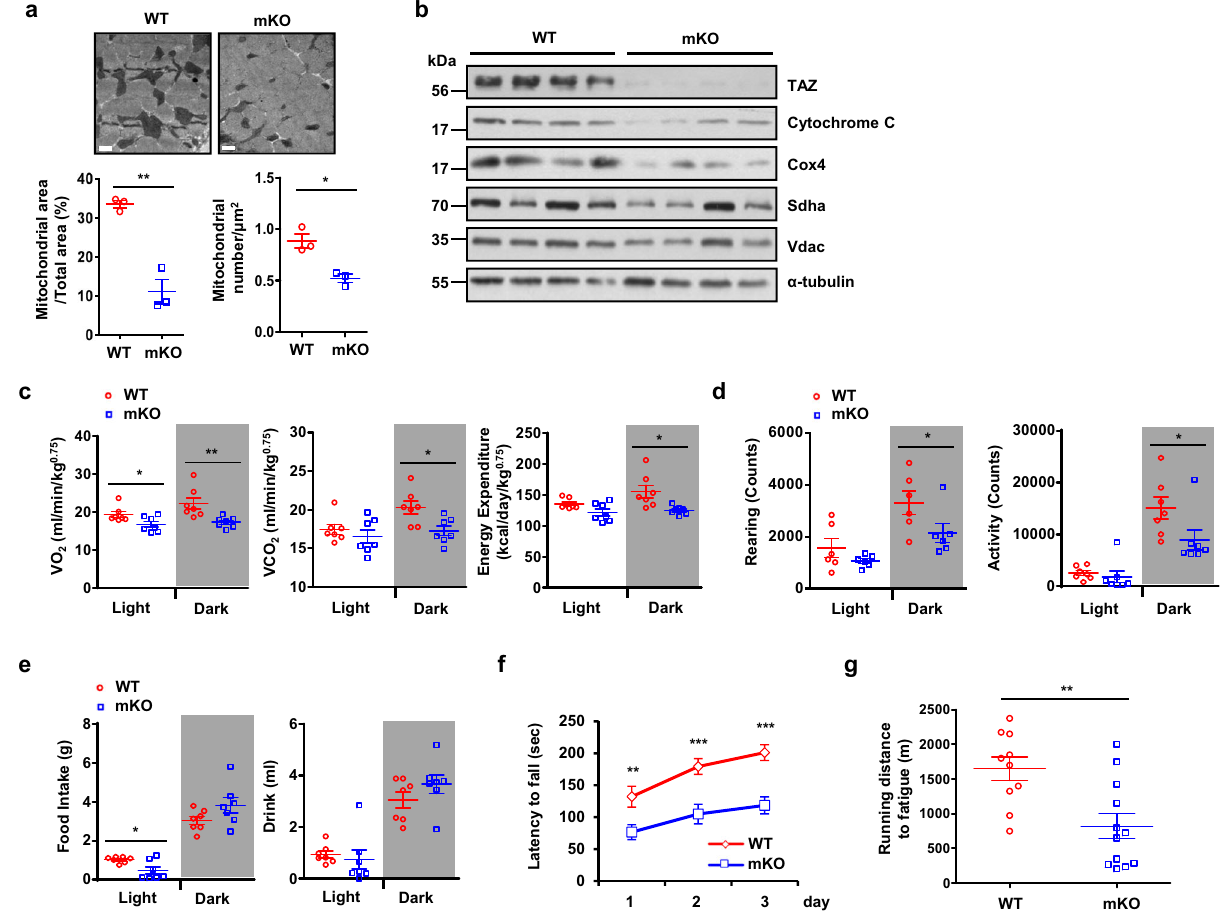
Fig. 1 TAZ knockout in muscle decreases mitochondrial mass, respiration, and exercise ability. a Images of the gastrocnemius muscle of wild-type (WT) or muscle-speci fi c TAZ knockout (mKO) mice were acquired using a transmission electron microscope; the mitochondrial area or number of mitochondria per μ m 2 was counted and calculated using Image J. Scale bar = 0.5 μ m, n = 3 for each genotype (Mitochondrial area; * p = 0.022, mitochondrial number; * p = 0.0104). b Proteins of the gastrocnemius muscle of WT and mKO mice were analysed via immunoblotting for the detection of mitochondrial marker proteins. Alpha-tubulin was used as the loading control. Representative data was shown and the experiment was performed twice with similar